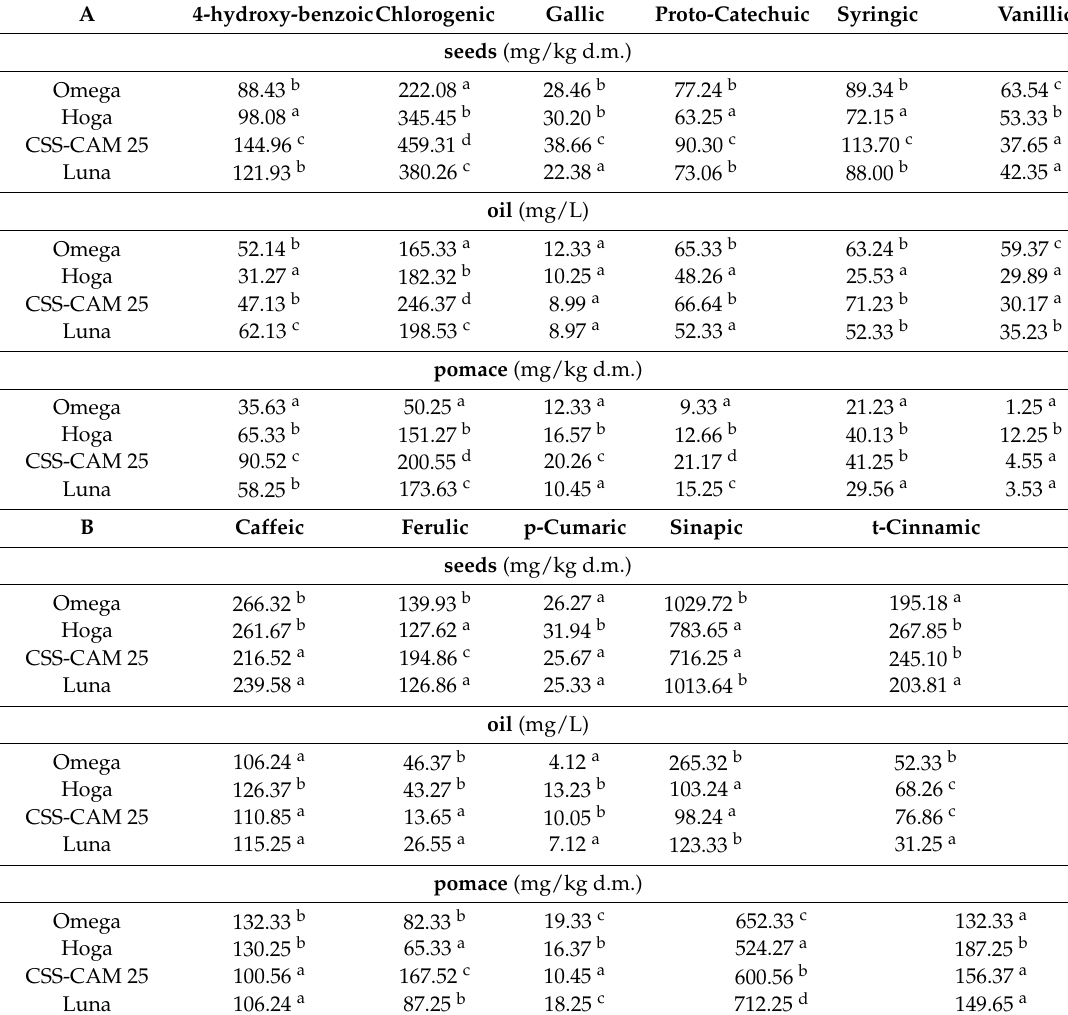
Table 2. The mean content of phenylcarboxylic (A) and phenylacrylic (B) acids (mg/kg) in spring and winter genotypes of Camelina